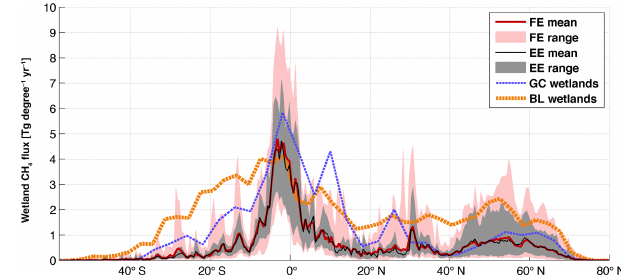
Figure 2. Mean wetland CH 4 emission zonal profiles: full ensem- ble mean (FE: red line) and corresponding range (pink area); ex- tended ensemble mean (EE; black line) and corresponding range (grey area); GEOS-Chem emissions inventory (GC; dashed blue line); Bloom et al. (2012) emissions (BL; dashed orange